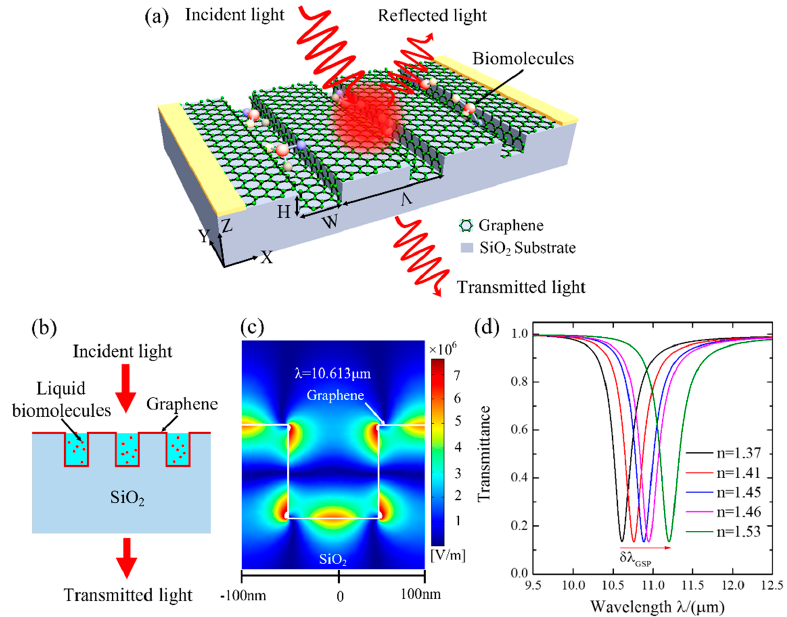
Figure 1. ( a ) Schematic of the conformal graphene-decorated nanofluidic channel (CGDNC) infrared sensor. ( b ) The cross section of the CGDNC. ( c ) The mode profiles of graphene plasmonics. ( d ) Transmission spectra when the refractive index of sensing medium is 1.37, 1.41, 1.45, 1.46, and 1.53, respectively (refractive indices of some typical molecules are in this range, such as double-stranded DNA [9]).